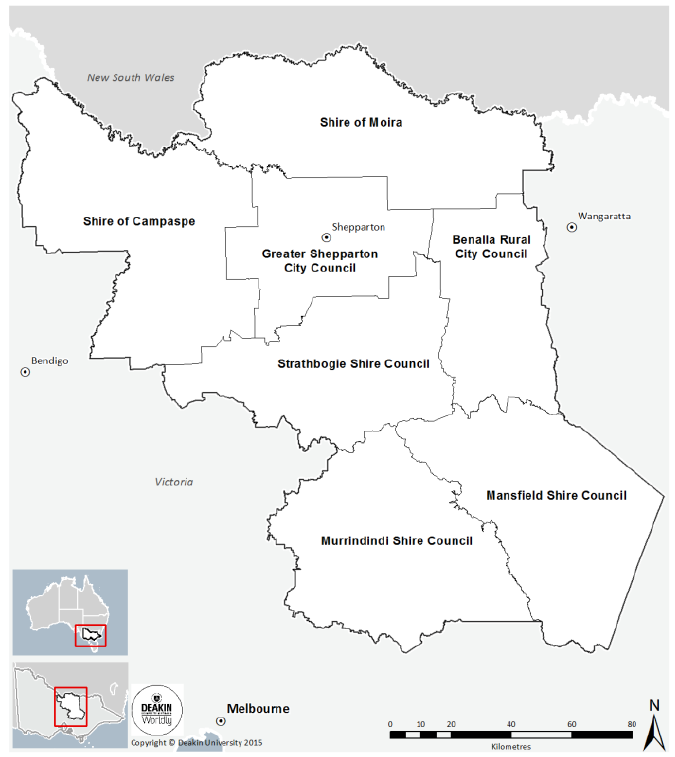
Figure 1. The Goulburn Broken Region, showing local government areas, Victoria, Australia.